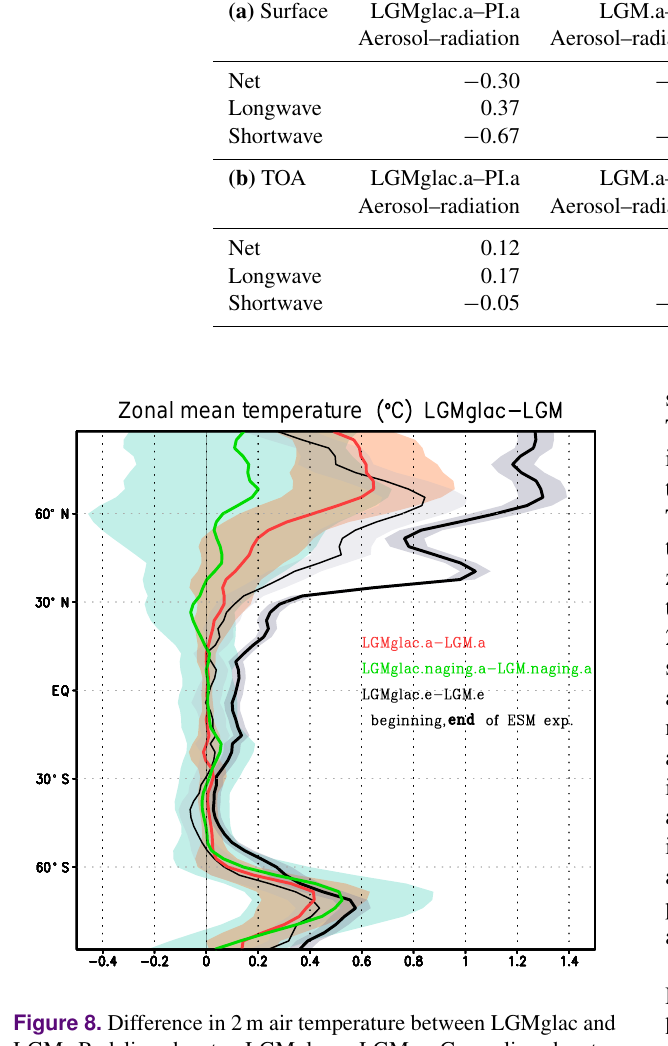
Figure 8. Difference in 2m air temperature between LGMglac and LGM. Red line denotes LGMglac.a–LGM.a. Green line denotes LGMglac.naging.a–LGM.naging.a, which means the change is not attributable to the ageing effect of snow. Thin and thick black lines denote LGMglac.e–LGM.e at the beginning (average of year 1 to 100 in Fig. 1) and the end (average of year 701 to 900) of the exper- iments, respectively. Shading represents the year-to-year standard